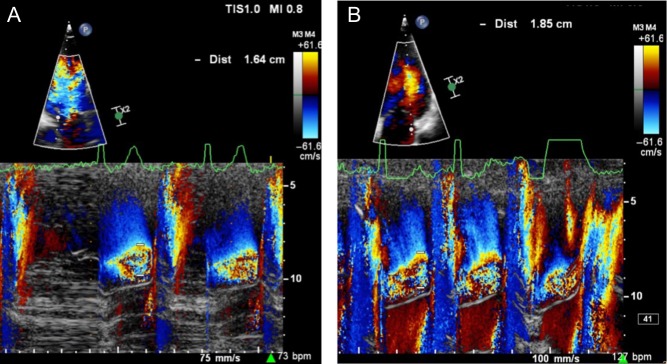
Colour M-mode demonstrating worsening MR in a patient with normal LVEF. There is an increase in PISA from rest (A) to exercise (B) while cycling at 75 W.